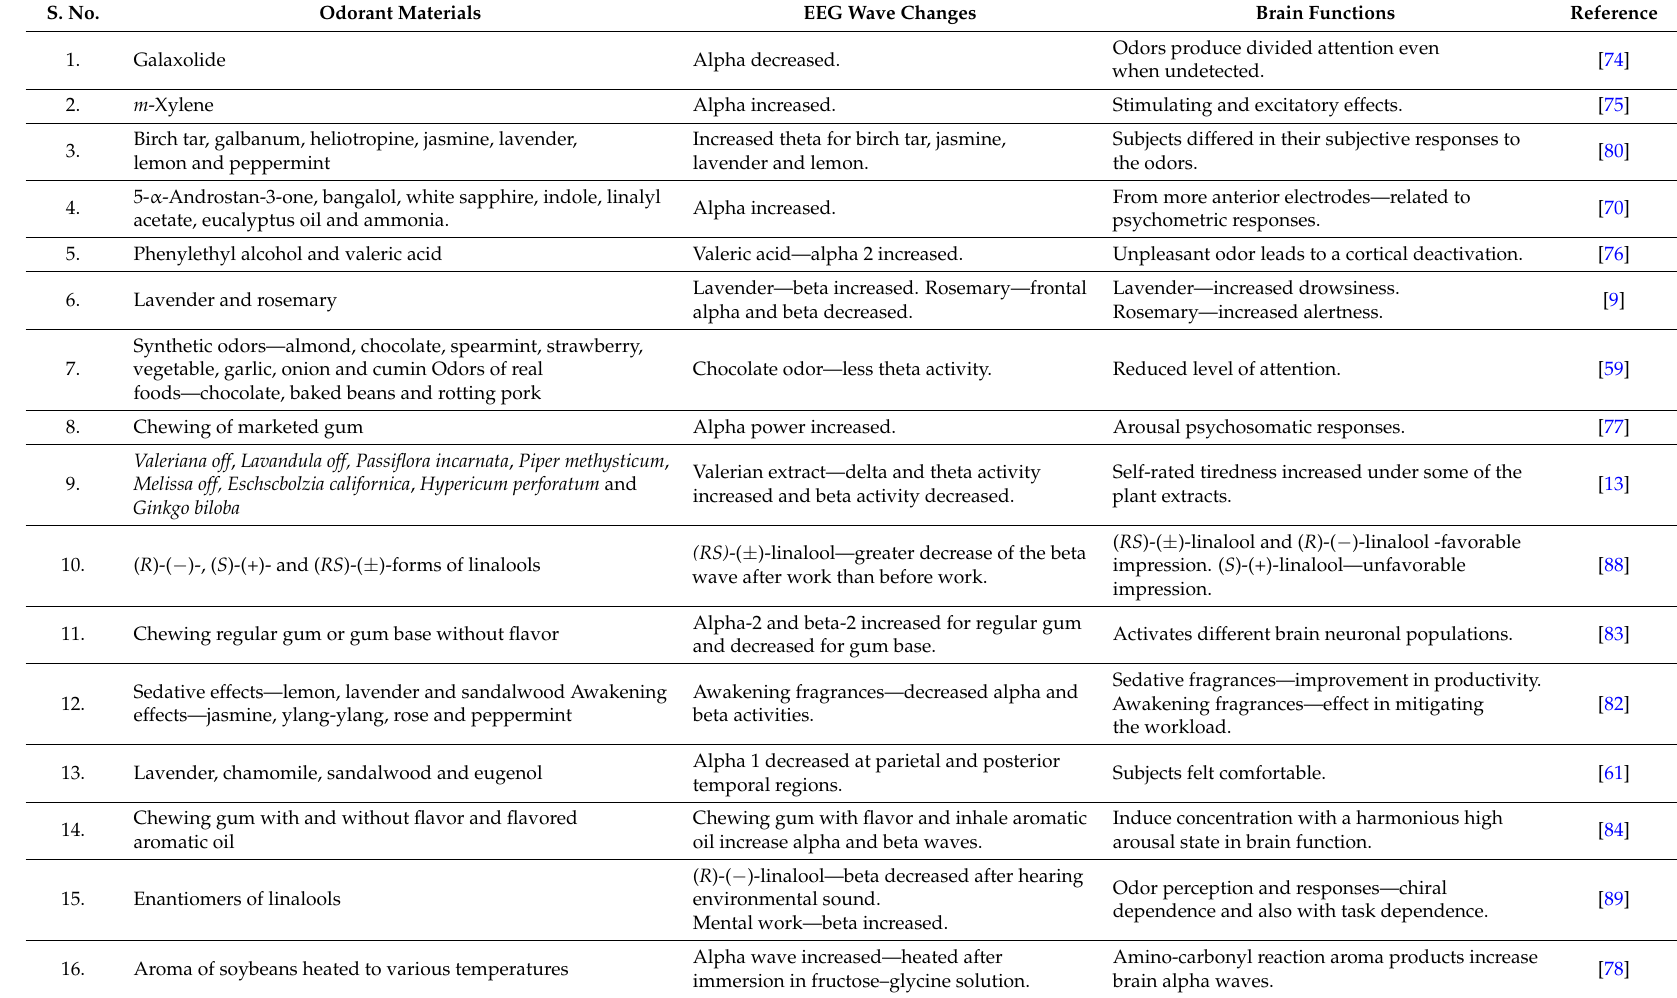
Table 2. Effect of inhalation of aroma on electroencephalograph (EEG)